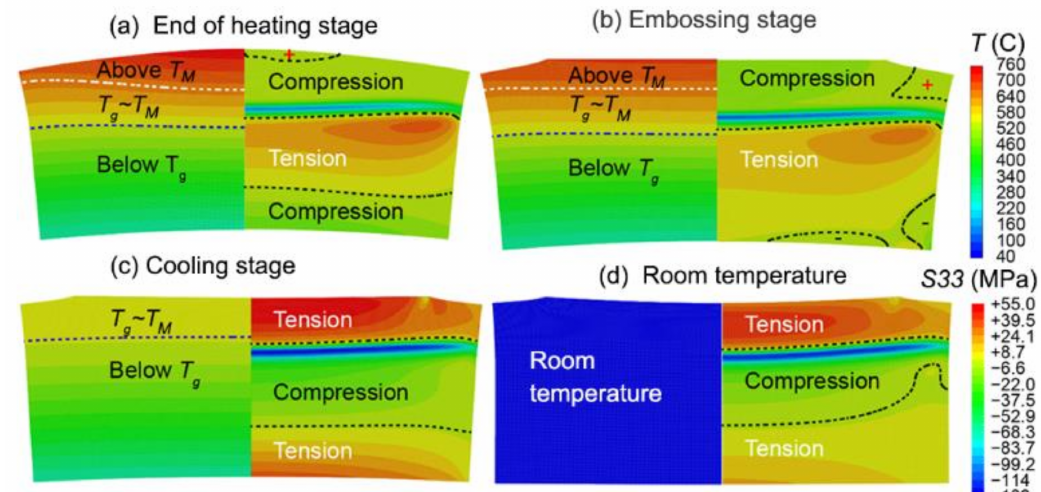
Figure 10. Illustration of temperature (left part of the contour) and hoop stress (right part of the contour) distribution contours at four different stages of embossing (glass viscosity = 10 8.0 Pa. s at T M ); ( a ) End of heating stage; ( b ) Embossing stage; ( c ) Cooling stage; ( d ) Room